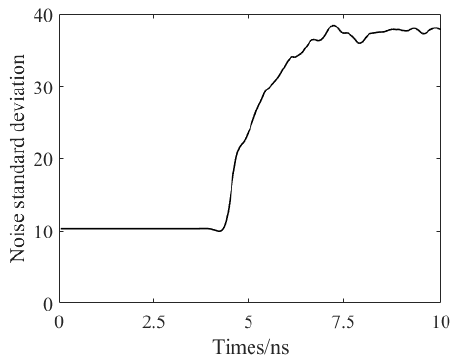
Figure 7. Simulated noise trend curve.